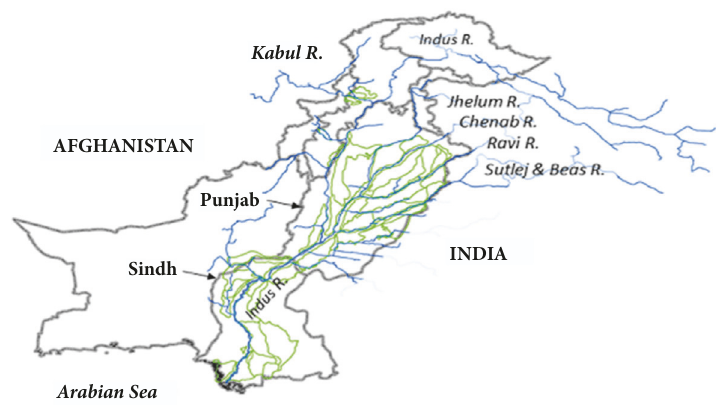
Figure 4: Rivers and irrigation network of